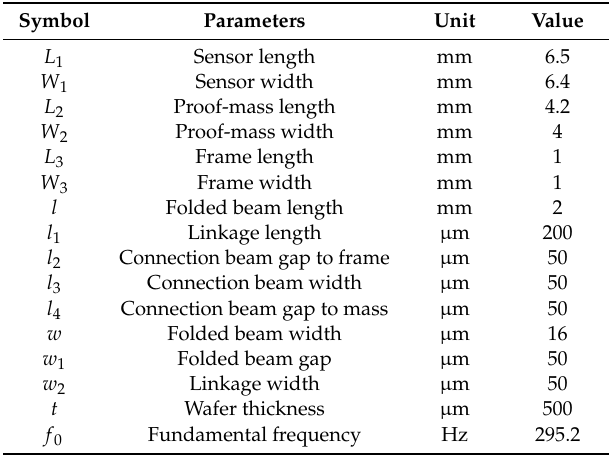
Table 1. Design parameters of the spring-mass structure.